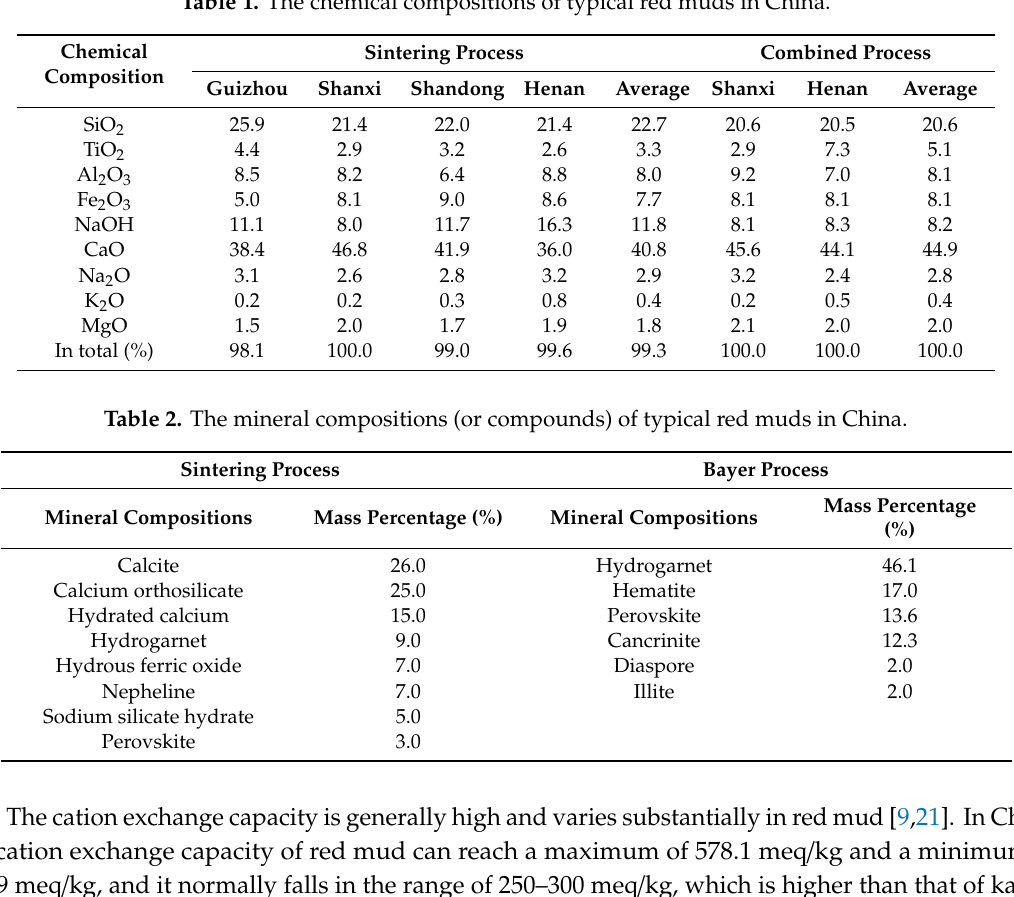
Table 1. The chemical compositions of typical red muds in China.